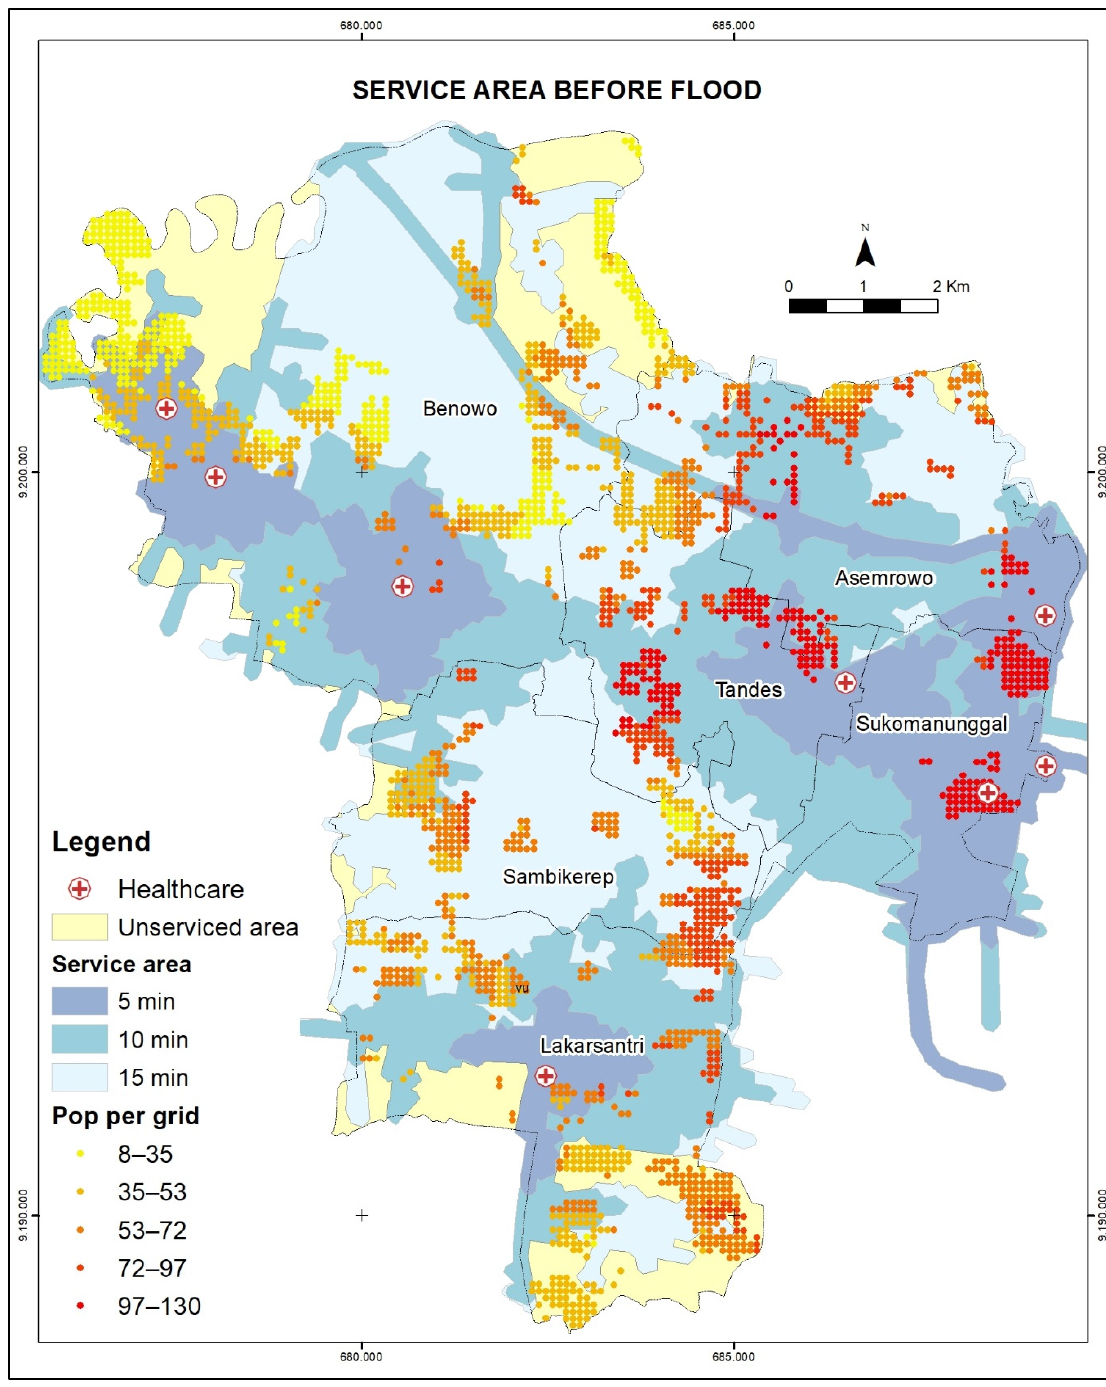
Figure 9. Healthcare service area before flood.